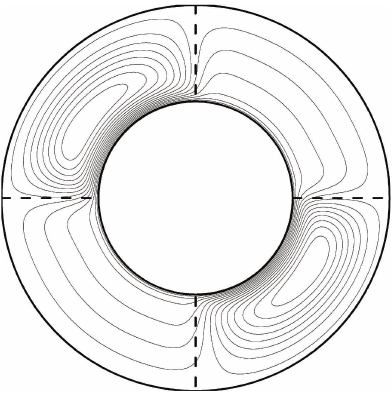
Figure 7: Distribution of the contours of stream function for two-quarter circular external magnetic fluids of Ha (cid:8) 30 (cid:2)Δ ψ (cid:8) 0 . 00025 (cid:3)